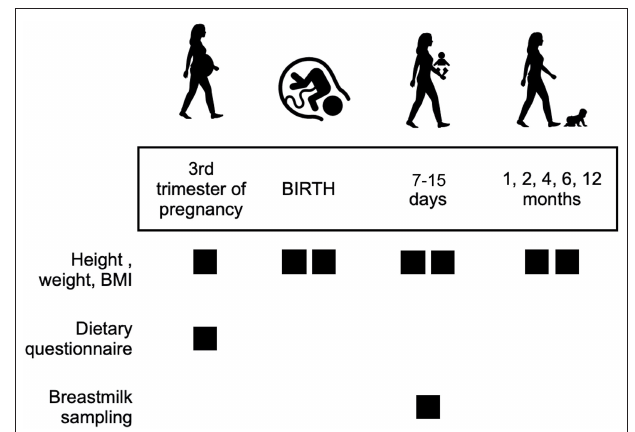
FIGURE 1 | Overview of the study